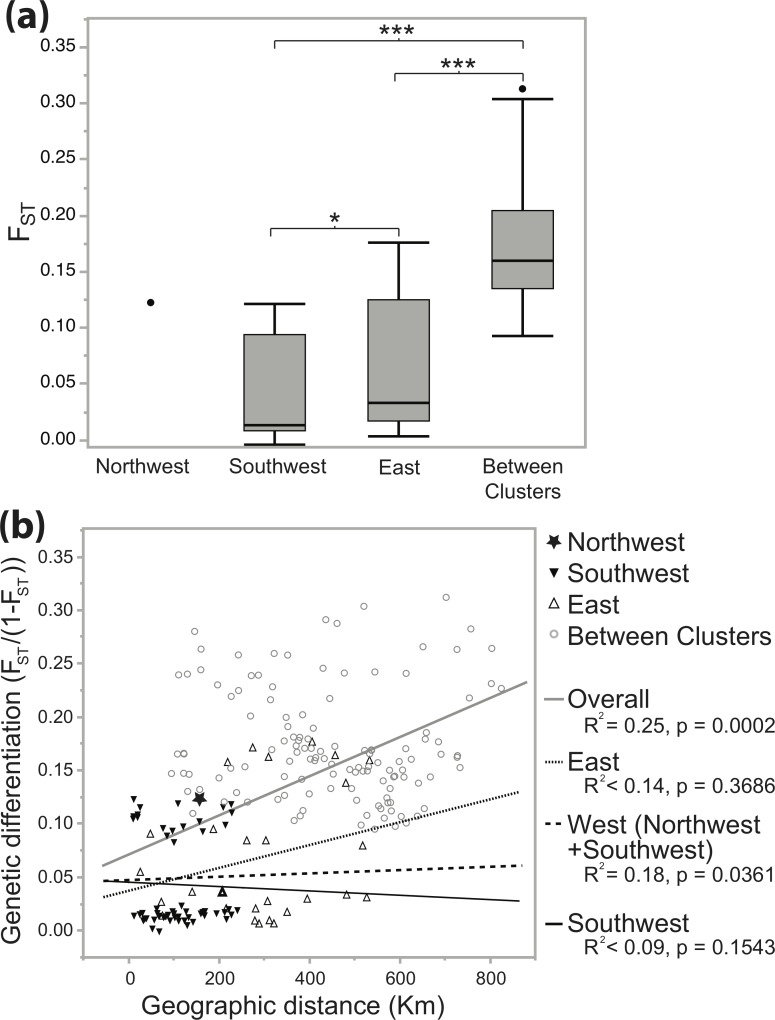
Comparison of FST among and between clusters, and relationship between FST and geographic distance.(a) Genetic differentiation (FST) computed in Arlequin [44] based on Weir and Cockerham 1984 [65] within and among clusters. Box plots show the mean, 1st and 3rd quartile, 95% quantiles (whiskers) and outliers (dots). Student’s t-tests indicated that average FST was significantly lower in the Southwest than the East (p = 0.0273, marked *), and significantly higher between-cluster comparisons than in the southwest or east (p < 0.0001, marked ***). (b) Genetic versus geographic distance using FST/(1- FST) to correct for finite population sizes [66] plotted for the northwest (star), southwest (downward pointing triangles), east (upward pointing triangles), and between clusters (grey circles), with linear line of best fit with R2 and p-values for Mantel tests for isolation by distance [66,68] performed in the “isolation by distance” web service v3.23 [67].